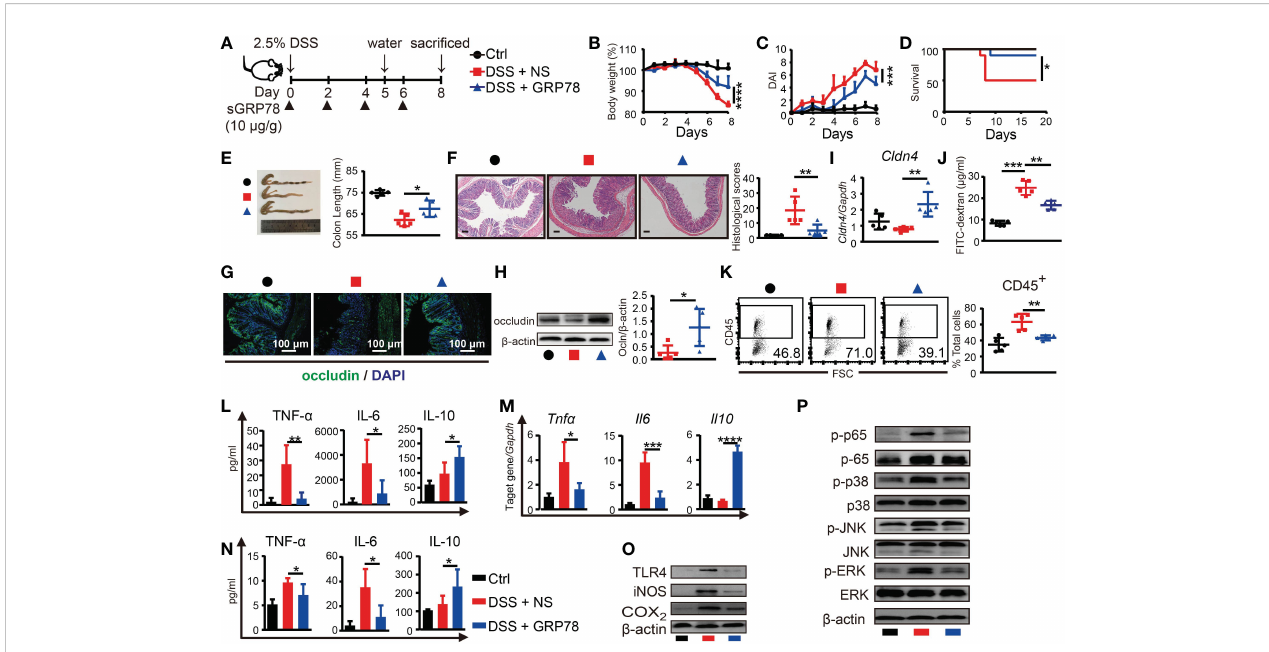
FIGURE 3 sGRP78 mitigates DSS-induced colitis and effects of sGRP78 on cytokine pro fi le. (A) Timetable scheme showing DSS and sGRP78 administration in mice. Effect of sGRP78 on (B) weight loss, (C) DAI score, (D) survival rate (n=10) in DSS exposed mice. At the end of observation (day 8 of experiments), mice were sacri fi ced and the colonic tissues were removed for following measurements: (E) Representative gross picture of colons (left) and quanti fi cation of colon length (right). (F) Representative HE-staining (left) and respective colitis scores of indicated groups (right). Scale bar: 100 m m. (G) Representative immuno fl uorescence images of occludin. (H) Occludin and (I) Cldn4 levels measured by WB and RT-qPCR. (J) FITC-dextran assay. (K) Frequencies of CD45 + cells in single-cell suspension of colon tissues. Results are expressed as the mean ± SEM (n=5 except fi gure D). * p <0.05, ** p <0.01. Black circle stands for vehicle control, red square for DSS+NS group and blue triangle for DSS+sGRP78 group. (L) Levels of cytokines in colonic tissues culture supernatant. (M) mRNA expression of Tnf a , Il6 and Il10 in colonic tissues. (N) Plasma concentrations of cytokines. IL-6 and TNF- a were measured by CBA and IL-10 by ELISA. (O) Western blot analysis of the expression of TLR4, iNOS, COX 2 , (P) MAPKs and p65 in colonic tissues. Data represent mean ± SEM (n=5). * p < 0.05, ** p < 0.01, *** p < 0.001, **** p <